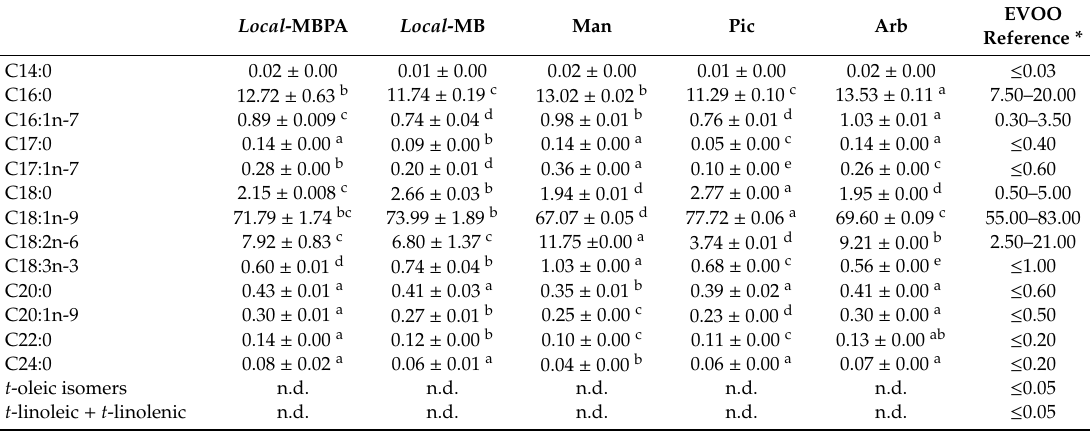
Table 1. Fatty acids (expressed as % of total fatty acids) of the studied virgin olive oils. Local -MBPA Local -MB Man Pic Arb